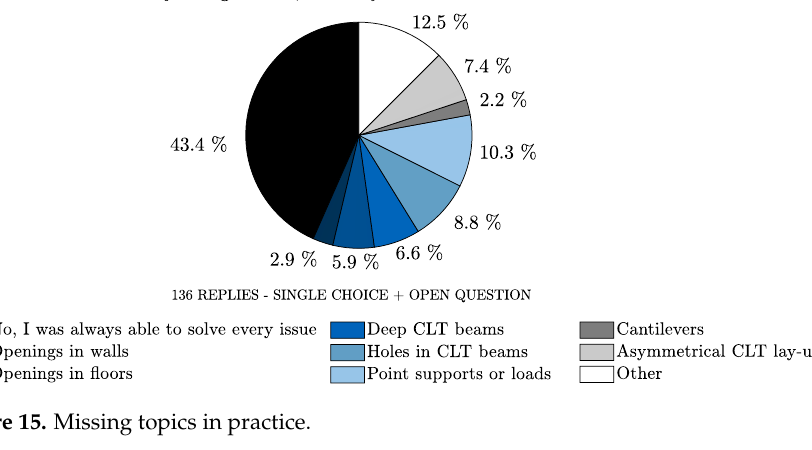
Figure 15. Missing topics in practice.